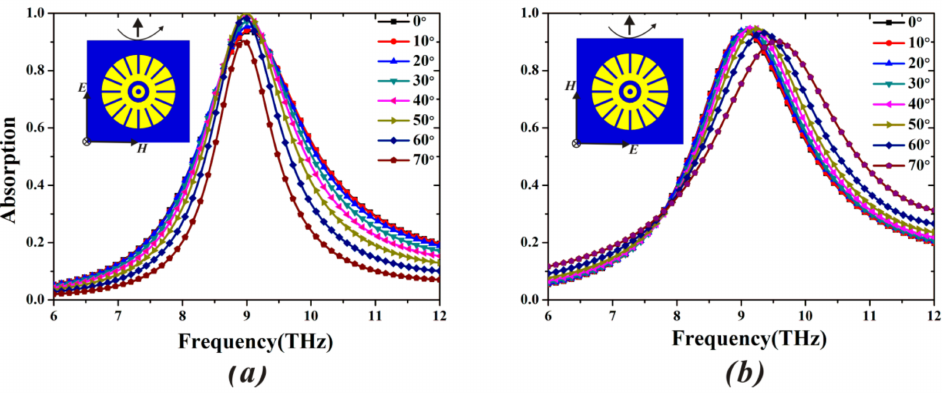
Figure 6. Simulated absorptivity under different incident angles from 0 ◦ to 70 ◦ for ( a ) TE mode and ( b ) TM mode.